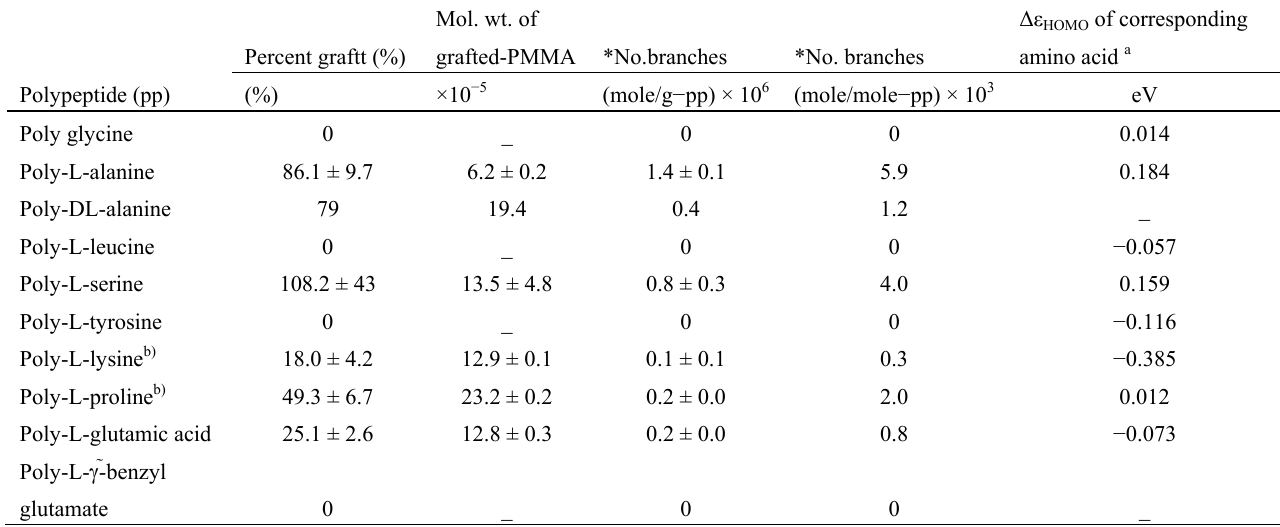
Table 2. Tri- n -butylborane-initiated graft copolymerization of methyl methacrylate with hydrated synthetic poly-L-peptides. Mol. wt. of Percent graftt (%) grafted-PMMA